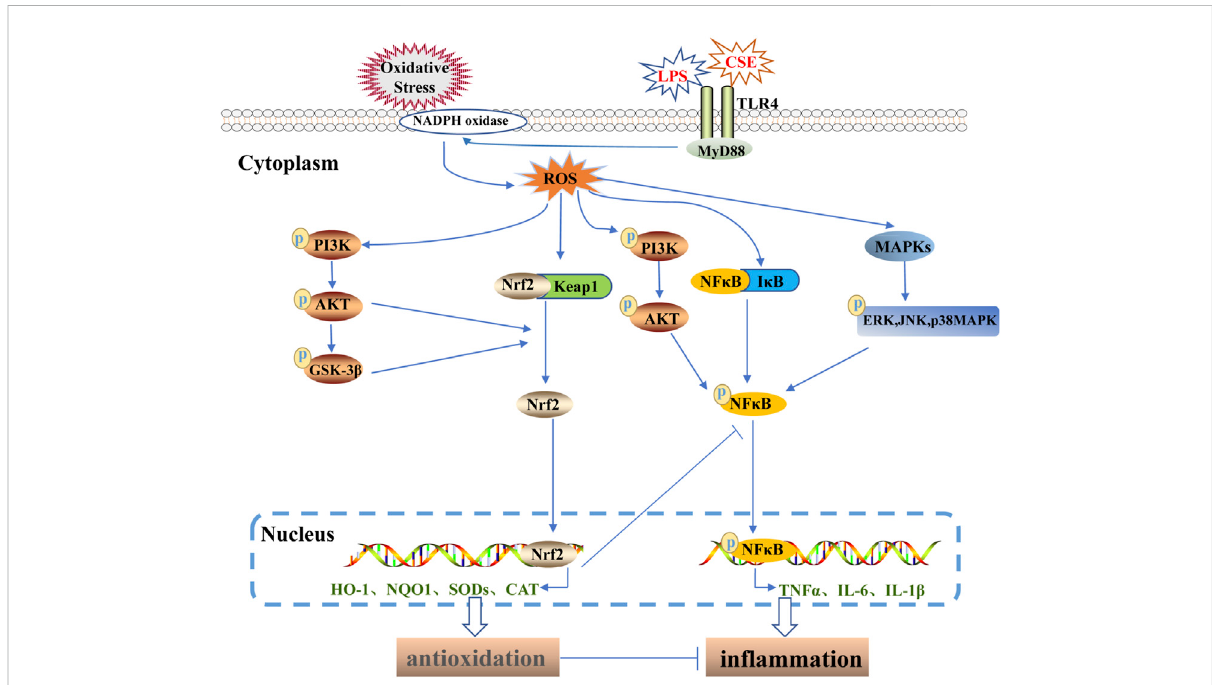
FIGURE 3 Regulation of lung in fl ammation and oxidative stress by Nrf2 signaling pathway crosstalk. Bacteria, viruses, harmful gases, and other stimuli induceexcessiveoxidativestressandin fl ammatorydamageinthelungs.AnimalstudieshaveshownthatToll-likereceptor-inducedROSproduction canbeactivatedbyendotrachealinfusionoflipopolysaccharide(LPS)orinhalationofcigarette smoke(CSE)inmice.ExcessiveROSdirectlyactivates the NF κ B in fl ammatory pathway and the phosphorylation of AKT, ERK, JNK, and p38MAPK by activating the PI3K/AKT and MAPK in fl ammatory pathways, inducing the transfer of NF κ B into the nucleus to promote the production of in fl ammatory factors (TNF α , IL-6, IL-1 β ). In addition, ROS directlypromotesnucleartranslocation ofNrf2andinducesnucleartransferofNrf2throughenhancedphosphorylationofAKTandGSK-3 β ,thereby promoting theexpressionofdownstream antioxidant factorsand inhibiting theNF κ Bin fl ammatory pathway. When ROS overproduction occurs, the Nrf2/ARE antioxidant pathway is unable to maintain a balance between oxidation and antioxidation, resulting in oxidative and in fl ammatory damage to the